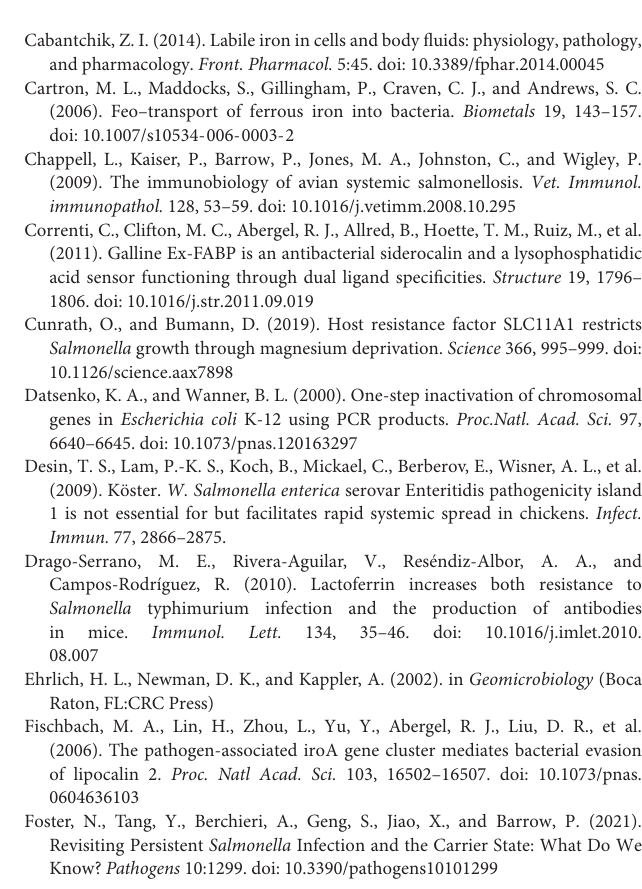
Supplementary Figure 2 | Infectivity of bioluminescent strains vs. non-bioluminescent strains as obtained by liver and spleen enrichments. Dark